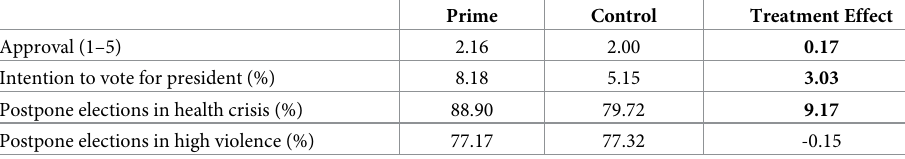
Table 1. Prime experiment results: Attitudes toward the